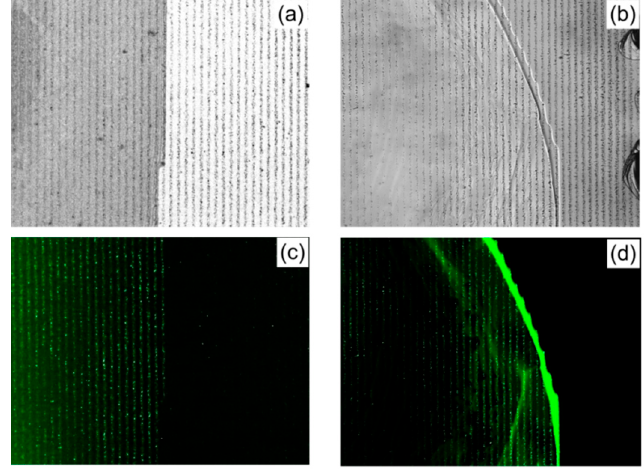
Figure 9. Optical microscope images ( a , b ), and FL microscope images ( c , d ), showing two droplets of fluorescein labelled biomolecules deposited on an Ag ‑ nanoparticle periodic pattern: DNA for ( a , c ) and synthetic peptide for ( b , d ) solution droplets. Reprinted with permission from Elvira et al. Adv. Mater. Technol. 2017 , 2 , 1700024. Copyright 2017 John Wiley and Sons (reference [36]).